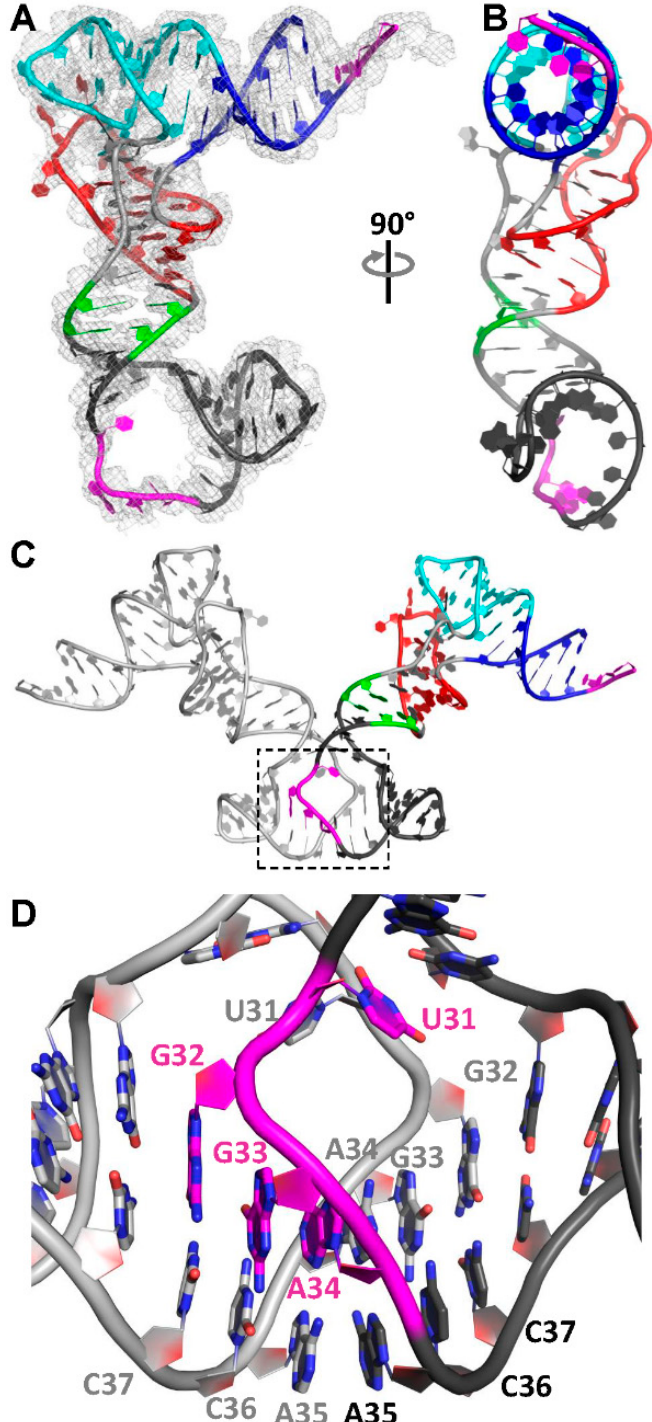
Figure 3. The 2.95 Å resolution crystal structures of tRNA–antiterminator fusion Construct #4 in space group C 222 1 . ( A ) Cartoon representation with 2 F o -F c electron density contoured at 1.0 σ , shown as a mesh. ( B ) Part A rotated 90 ◦ and shown without electron density. ( C ) Overall structure crystal packing across the antiterminator bulge and ( D ) close-up of the antiterminator bulge interactions highlighted by the dashed box in Panel C. Nucleotide numbering corresponds to numbering in the full-length construct. Coloring as in Figure 1 schematic, with the acceptor stem (blue), D-loop (red), T-loop (cyan), anticodon stem (green), antiterminator insertion (black), and the T-box sequence and tRNA UCCA tail (magenta).